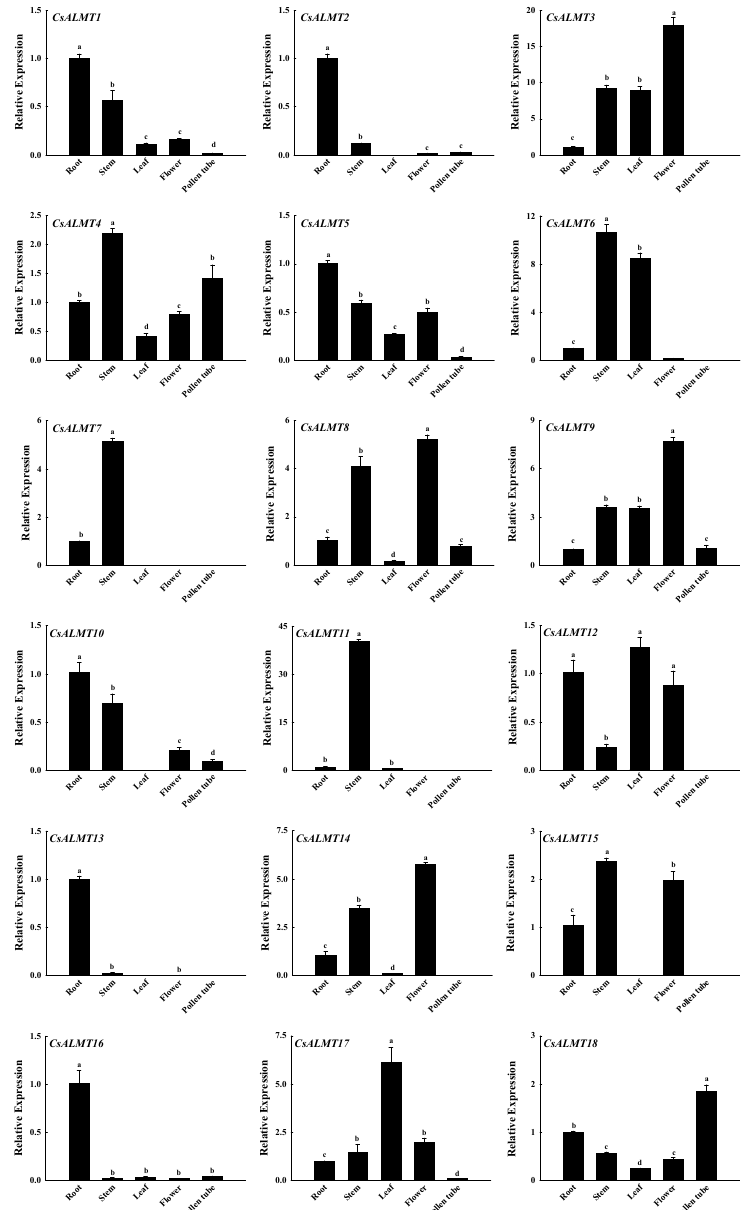
Figure 3. The expression level of CsALMTs in different tissues of Camellia sinensis . Different lowercase letters represent significant differences among different tissues (n = 3, p < 0.05), as determined by the Duncan test.